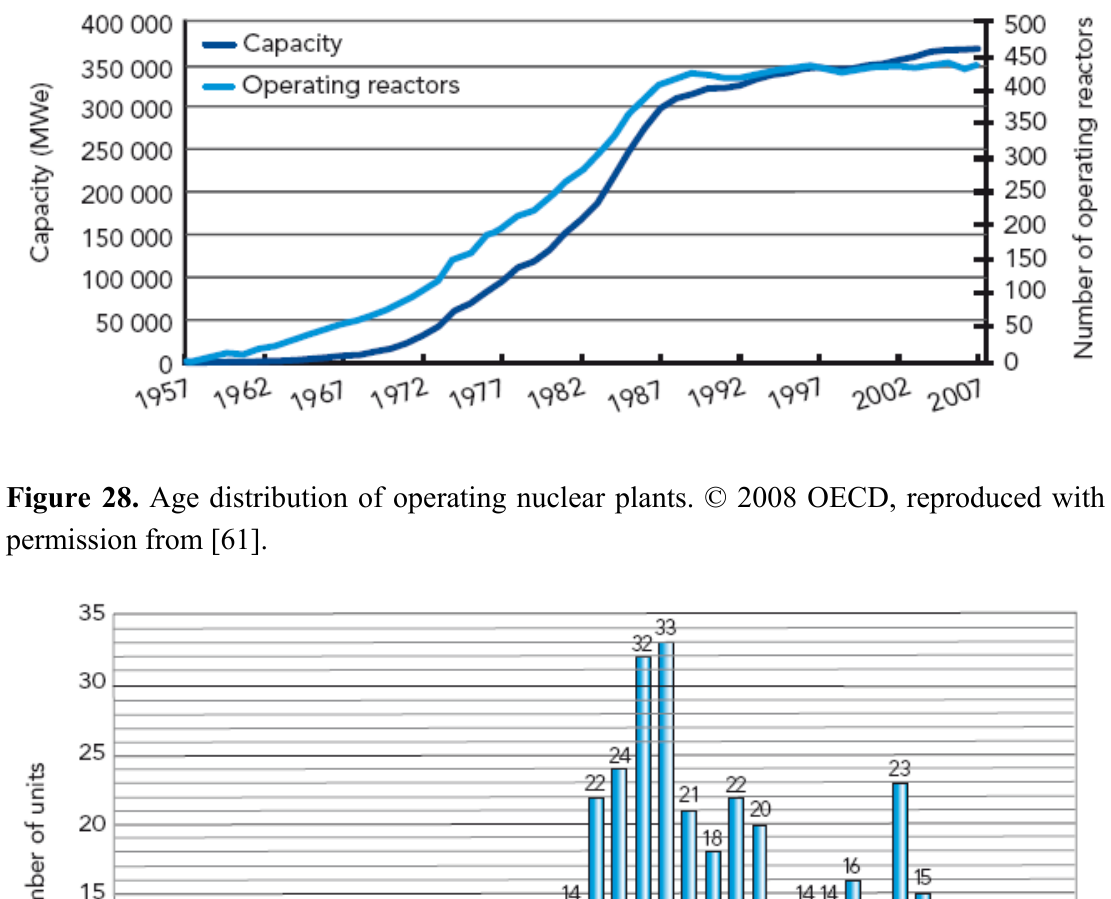
Figure 27. Global nuclear power capacity and reactors in operation. © 2008 OECD, reproduced with permission from [61].